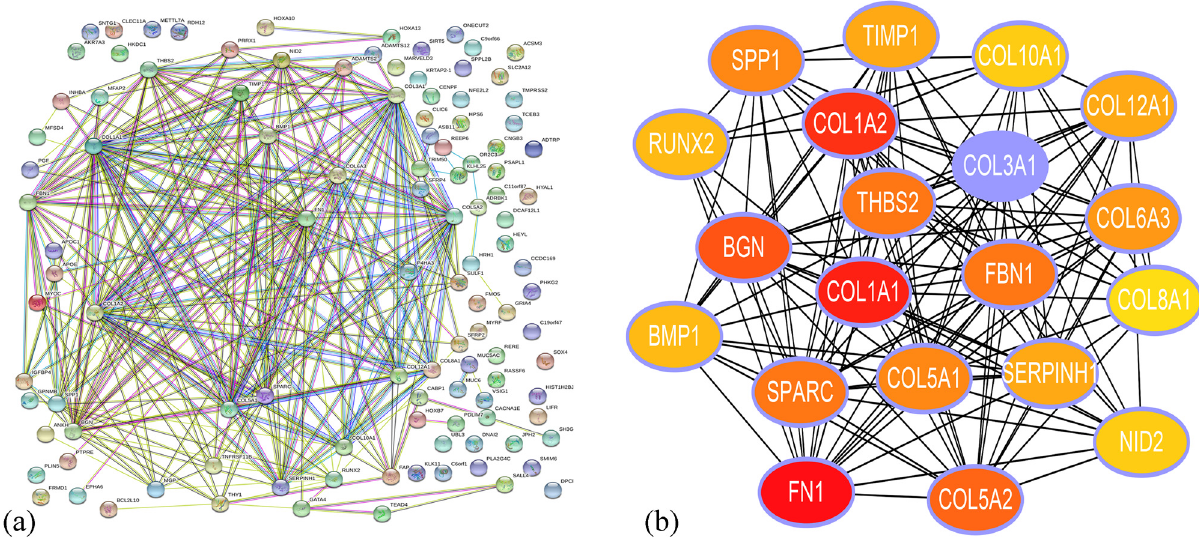
Figure 1: PPI analysis. ( a ) PPI network constructed from STRING. The network nodes represent proteins, and edges demonstrate the predicted functional associations between them. Seven di ff erent colored lines indicate the edges representing the seven types of evidence used in predicting the associations. The lines indicate the following evidence: red line – fusion; green line – neighborhood; blue line – co - occurrence; purple line – experimental; yellow line – text - mining; light blue line – database; black line – co - expression. ( b ) Twenty hub genes were obtained from the PPI network of DEGs using cytoHubba. The depth of the color represents the rank of the hub genes: red, blue, orange, and yellow indicate rankings in decreasing order; the darker the color, the higher the ranking is. PPI, protein – protein interactions; DEGs, di ff erentially expressed